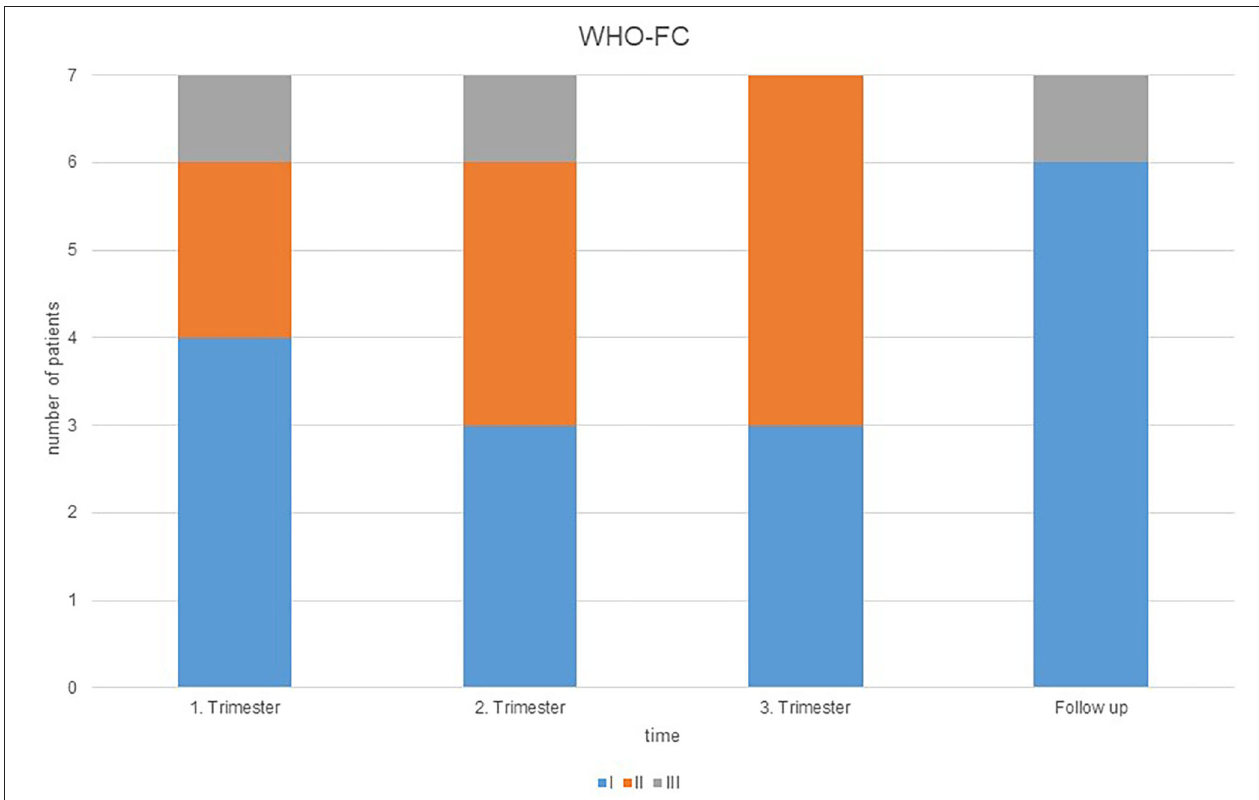
FIGURE 1 | Course of the World Health Organization functional class (WHO-FC) during pregnancy and at the first follow-up 3–5 months after